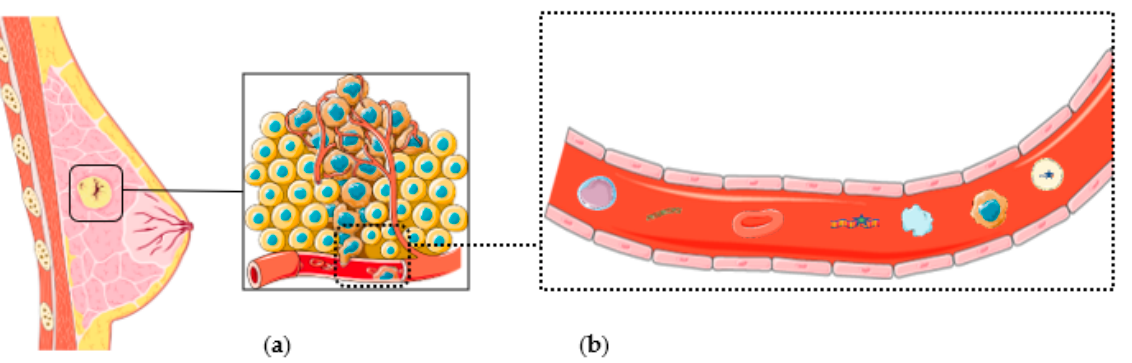
Figure 1. ( a ) Early breast cancer and relation between breast cancer cells and the vascular system. ( b ) Main components found in blood samples, from left to right: lymphocyte cell, cfDNA, erythrocyte, ctDNA, platelet, CTC, exosome with ctDNA.